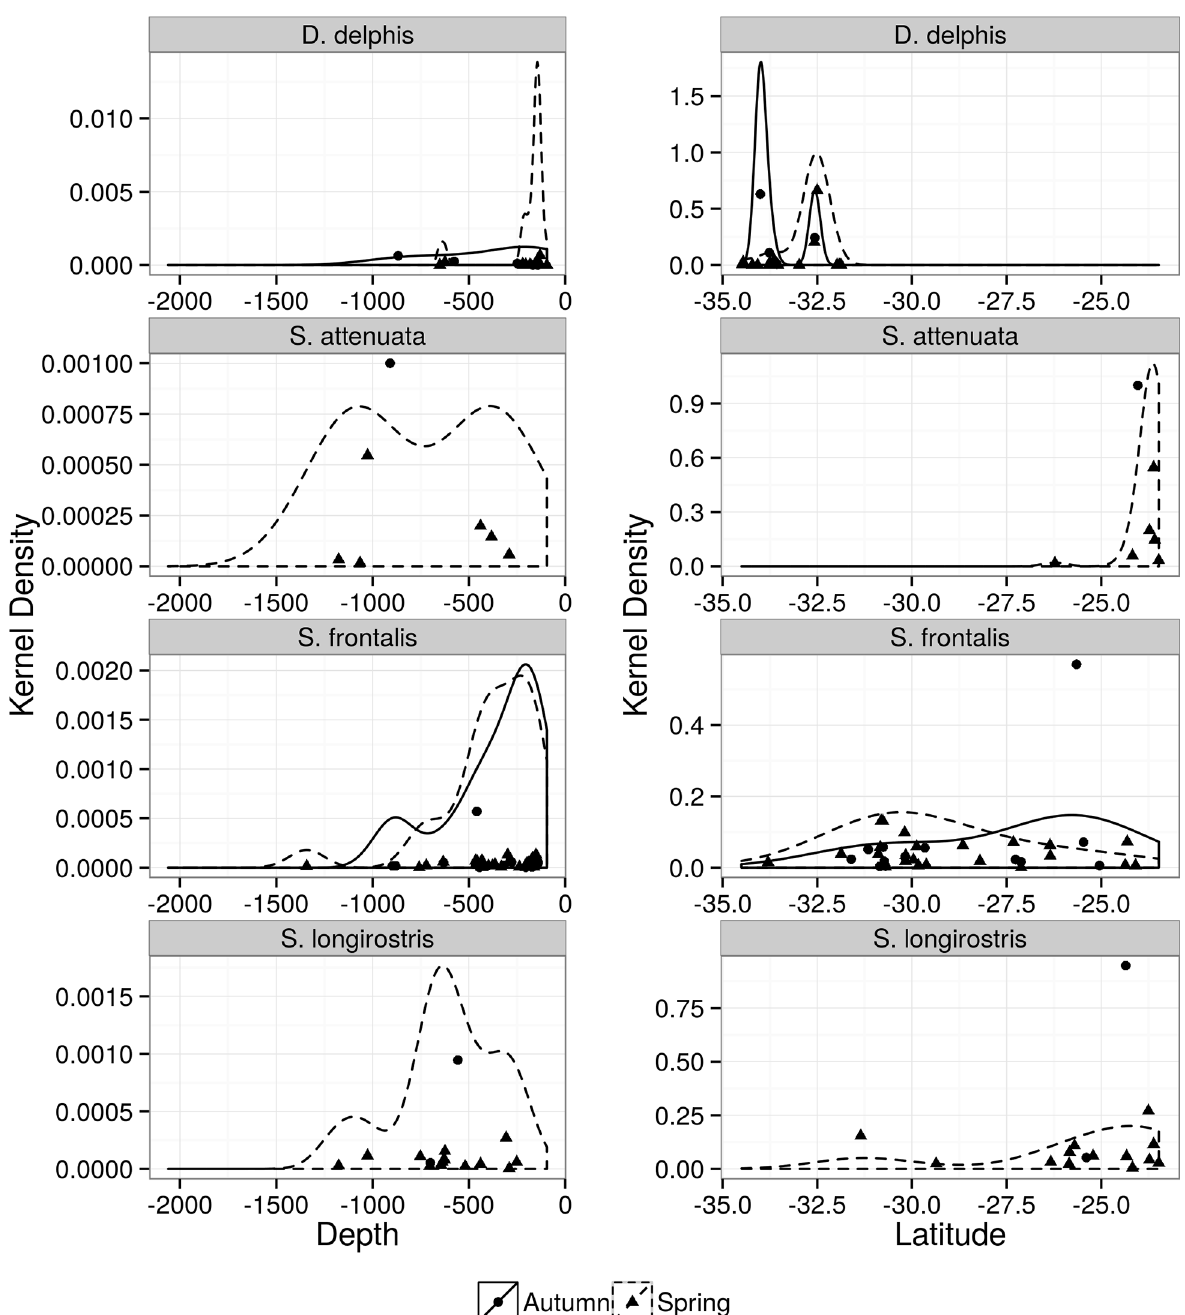
Fig 5. Kernel density distribution of Atlantic spotted dolphin ( Stenella frontalis ), short beaked common dolphin ( Delphinus delphis ), spinner dolphin ( Stenella longirostris ), pantropical spotted dolphin ( Stenella attenuata ). Plots are according to depth (left) and latitude (right) during spring (dashed lines) and autumn (solid black lines)